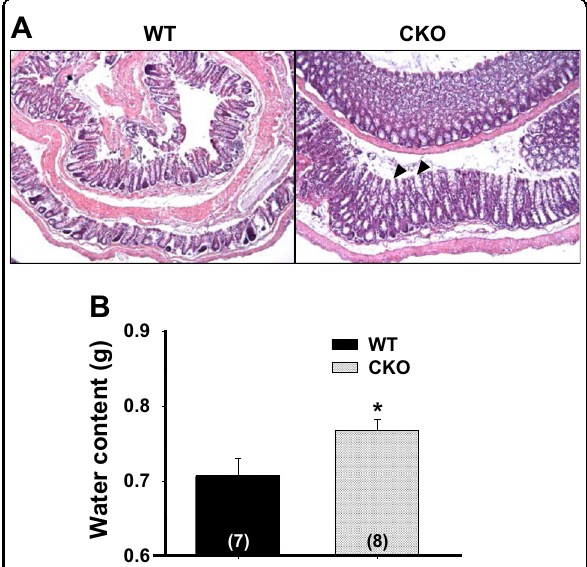
Fig. 5 Colons of Cdx2-Ano1 fl / fl mice in steady state depict mild edema. a Hematoxylin and eosin staining of colons from Ano1 fl / fl (WT) and Cdx2-Ano1 fl / fl (CKO) mice (Swiss roll preparation). There was marked thickening of the mucosal layer (arrowheads) and submucosal edema. b Water content in the stool was signi fi cantly increased in the CKO mice. The water content in the stool was measured by dividing the wet weight minus the dry weight by the wet weight of the stool. * p < 0.05. Error bars represent the SEM. The numbers in brackets represent the number of